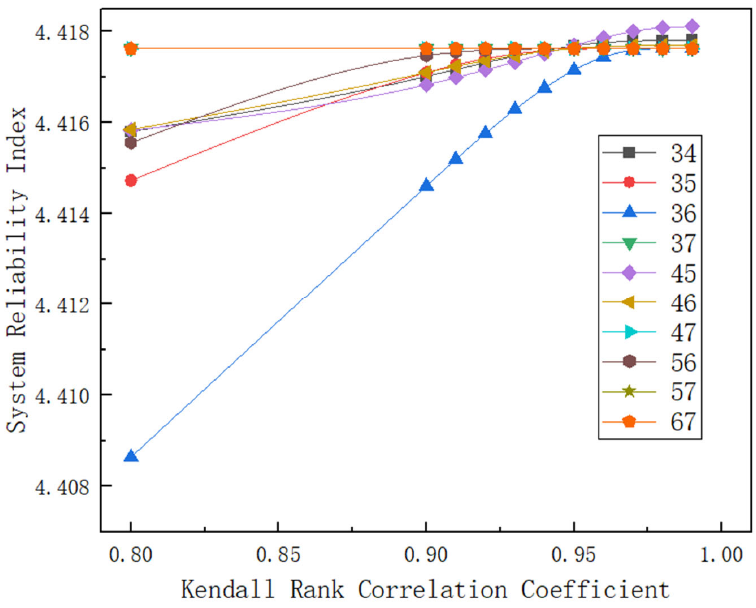
Figure 3. Effect of the change of the failure modes combination correlation coefficient on the relia ‐ bility index of the system.